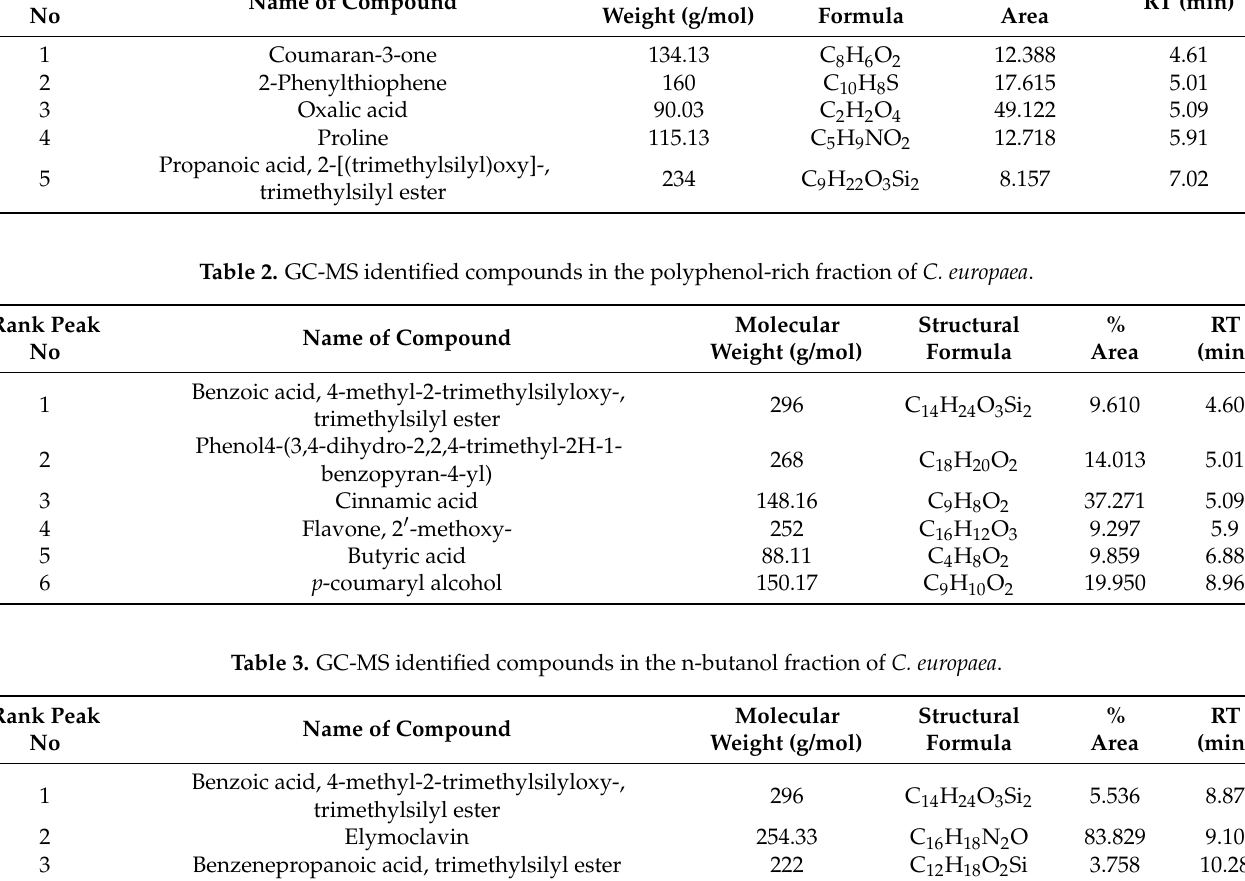
Figure 3. Chromatographic profile of n-butanol fraction of C. europaea after silylation. 1 : Benzoic acid, 4-methyl-2- trimethylsilyloxy-, trimethylsilyl ester; 2 : Elymoclavin; 3 : Benzenepropanoic acid, trimethylsilyl ester; 4 : 5-Hydroxy-6- methoxy-2-methyl-3-phenylbenzofuran (isoparvifuran). Table 1. GC-MS identified compounds in the hydroethanol fraction of C. europaea . Rank Peak